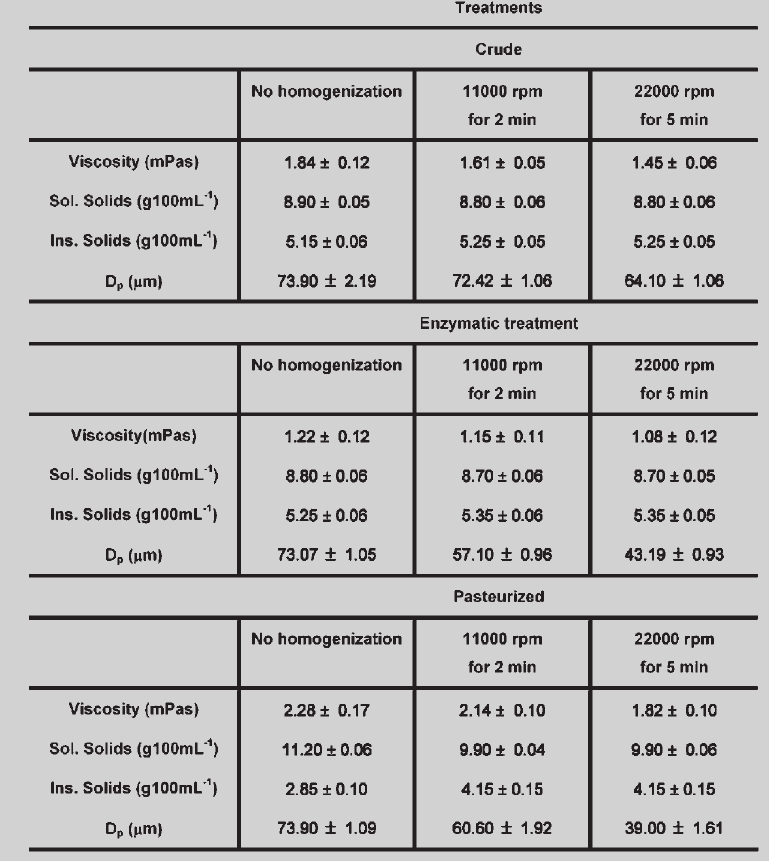
29 Applied Rheology